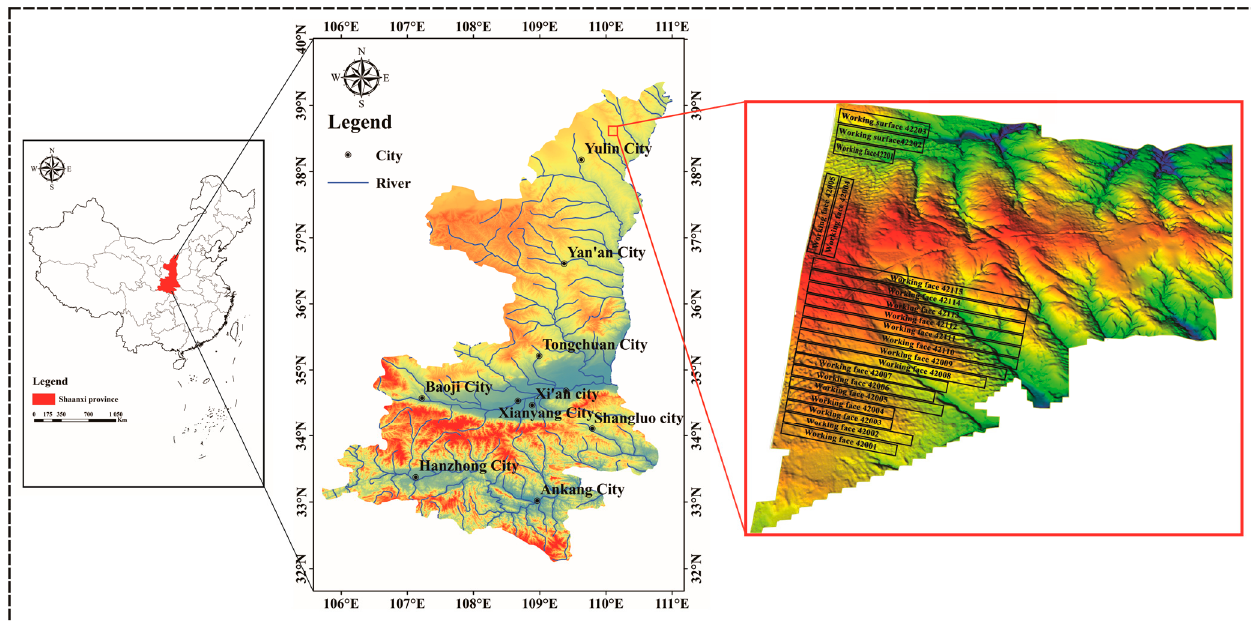
Figure 1. Geographical location of the mining area.